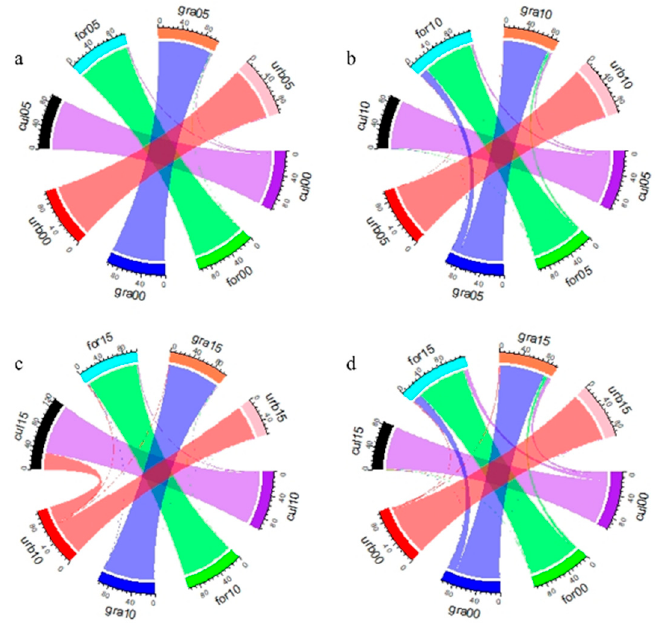
Figure 4. Change rate of different land types during 2000–2015: ( a ) 2000–2005, ( b ) 2005–2010, ( c ) 2010–2015, and ( d ) 2000–2015; urb, gra, for, and cul refer to urban, grassland, forest, and cultivated land; 00, 05, 10, and 15 represent 2000, 2005, 2010, and 2015.